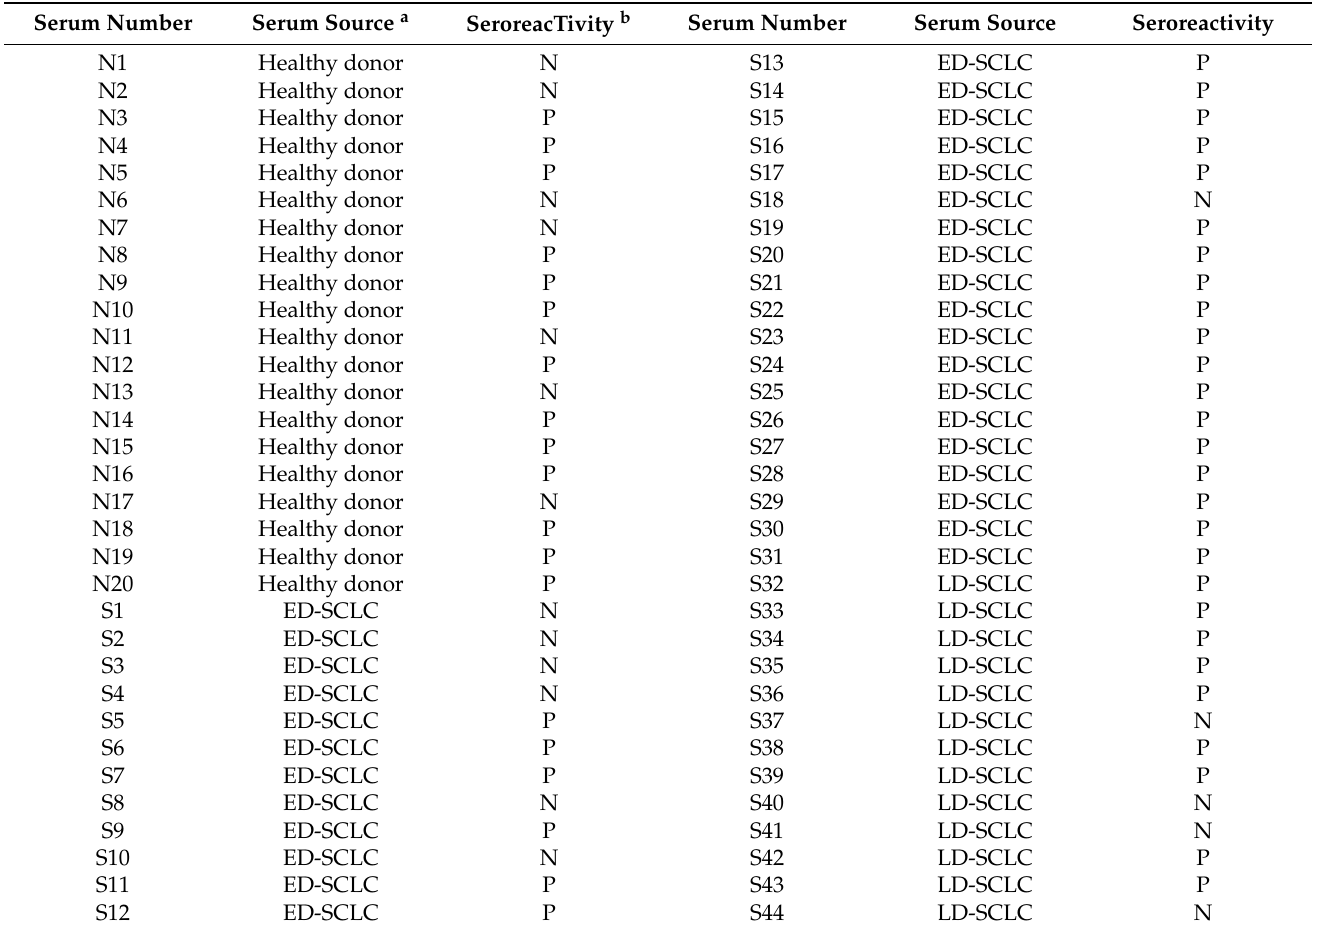
were tested for NOL4 reactivity by western blot analysis. As shown in Table 2 and Supple- mentary Materials Figure S1, humoral response against NOL4 protein was detected in 75% (33/44) of SCLC patients, and, more specifically, 77% (24/31) of extensive-disease-SCLC patients and 69% (9/13) of limited-disease-SCLC patients, respectively. On the other hand, it was found in 65% (13/20) of healthy patients. The correlation between NOL4 expression and positive IgG was not evaluated due to a lack of paired samples; therefore, this requires further investigation in a future study. Table 2. Summary of anti NOL4 antibodies in sera from SCLC patients and healthy